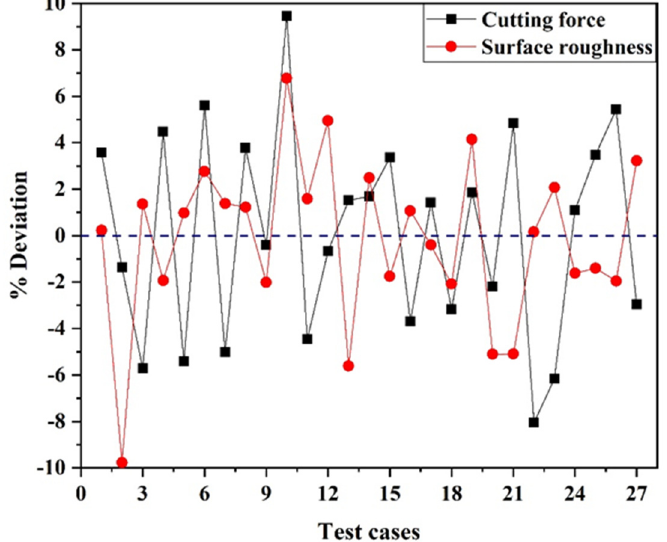
Figure 6. Deviation (%) between experimental and estimated results for cutting force and surface roughness in different test cases .